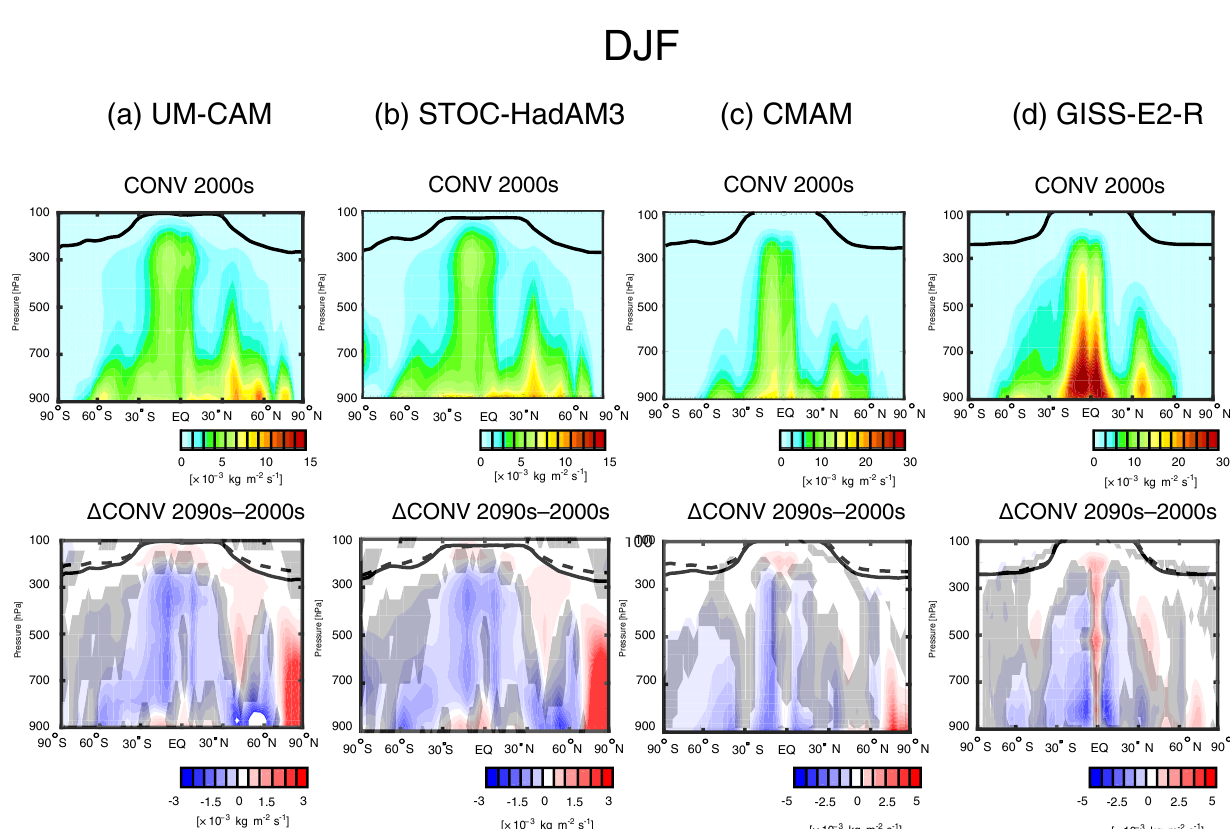
Figure 6. Top panels: DJF 10-year climatological mean zonally averaged convective mass fluxes for present day (1995–2006) for (a) UM- CAM, (b) STOC-HadAM3, (c) CMAM, and (d) GISS-E2-R. The thick black solid line represents the present-day (DJF) zonally averaged thermal tropopause. Bottom panels: differences between 2090–2099 (RCP 8.5) and 1995–2006 (present day) DJF climatological mean zonal- mean convective mass fluxes. The thick solid and dashed lines represent the DJF zonally averaged thermal tropopause for the present day and the 2090s (RCP 8.5) climatologies. Grey shading indicates where results are not significant at p < 0 . 05 as evaluated with a Student’s t test using 10 years of data for the 2090s (RCP 8.5) and present-day simulations. Note the different scales for (i) UM-CAM and STOC-HadAM3 and (ii) CMAM and